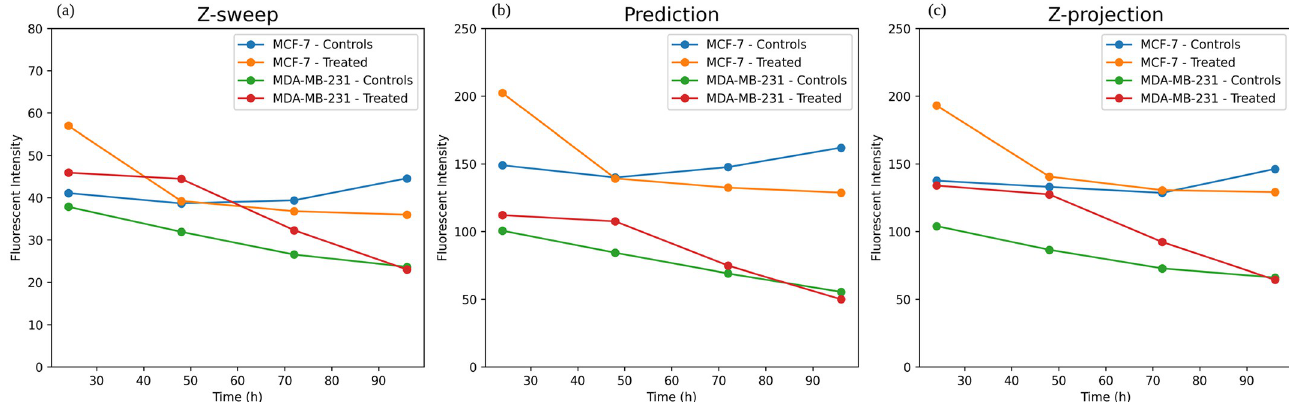
Fig 8. Time courses of nuclear-restricted mKate2 fluorescence intensities of embedded tumor spheroids. Quantified based on z-sweeps (a), OSA-CGAN predictions (b), and z-projections (c). Note the different scale of y-axis in A.